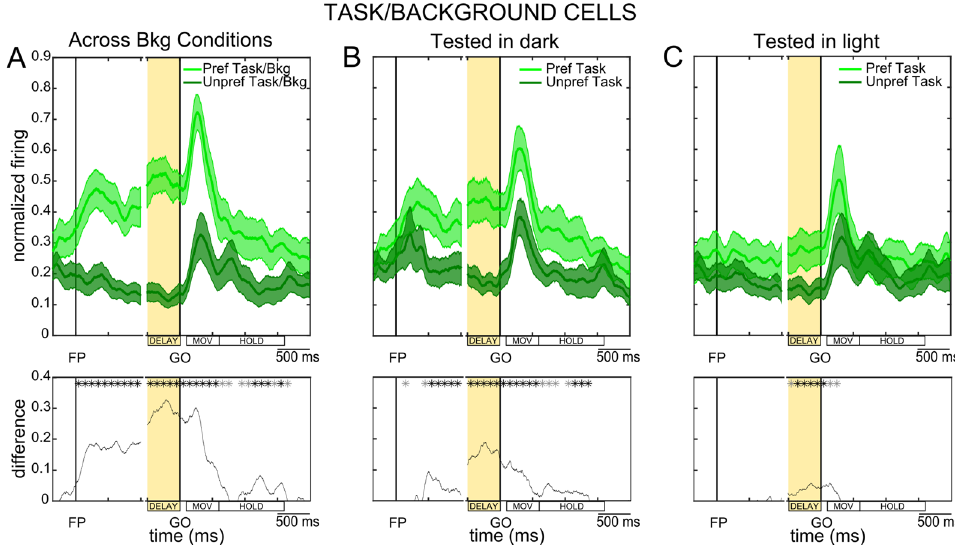
Figure 6. Combined selectivity for task and visual condition. ( A ) Population SDFs represent the temporal unfolding of combined task and background preference across the whole population of Task/Background cells , as assessed by averaging spiking activity during the preferred (in green) vs. unpreferred (in dark green) task and visual condition. ( B ) Population SDFs represent the temporal unfolding of task preference across the whole population of Task/Background cells , when tested with a dark background. ( C ) Population SDFs represent the temporal unfolding of task preference across the whole population of Task/Background cells , when tested with a light background. All conventions as in Fig.